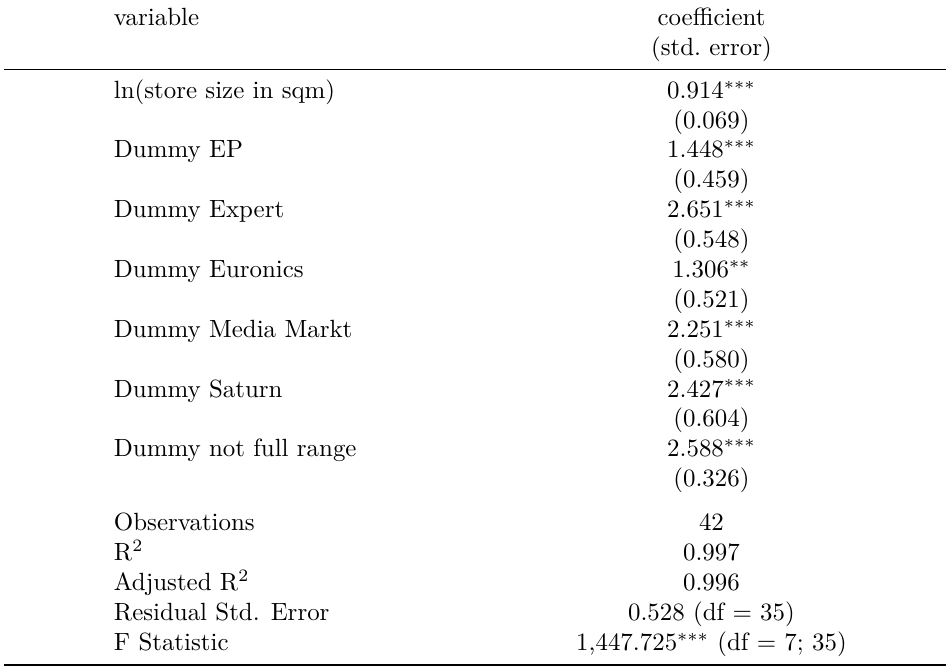
Table 2: Estimation results for the assortment model for consumer electronics stores – Dependent variable: ln(number of